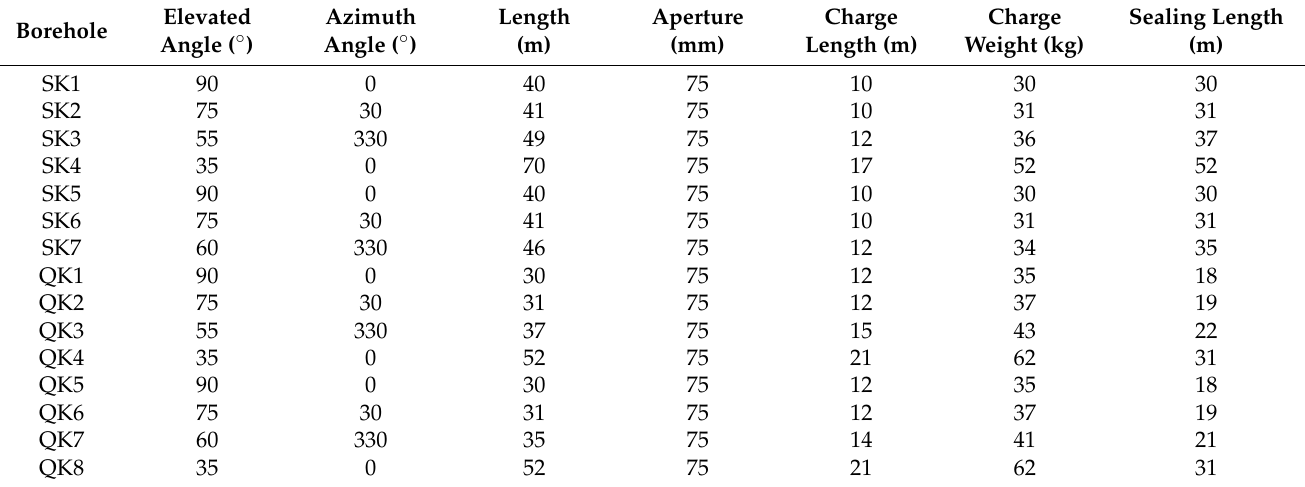
Table 4. Parameters for pre-splitting blasting